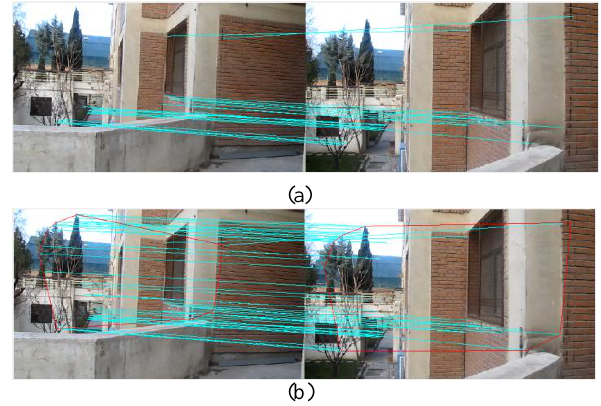
Figure 5. a. The result of this research, b. The result of Al- kaff